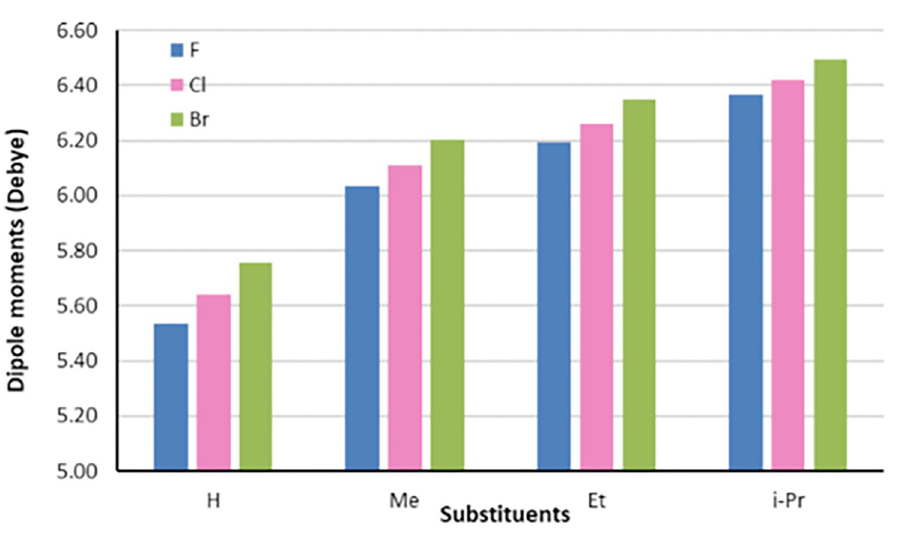
Fig 14. Dipole moments (Debye) in the gas phase at B3LYP/6-311+G(d,p) level for fuberidazole compounds (5a-